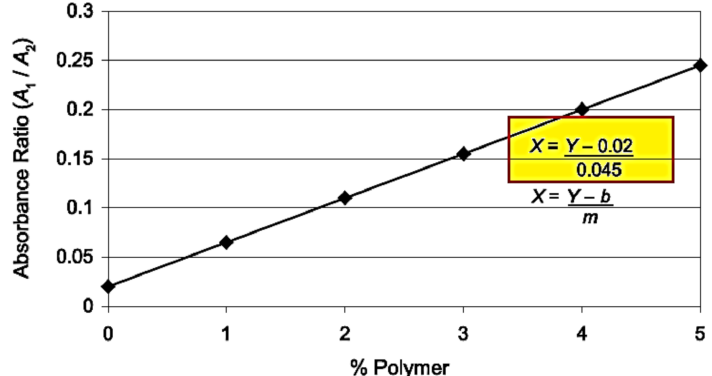
Figure 4. Calibration curve for determination of the percentage concentration of polymer in the transmission mode of analysis, according to AASHTO T302–15